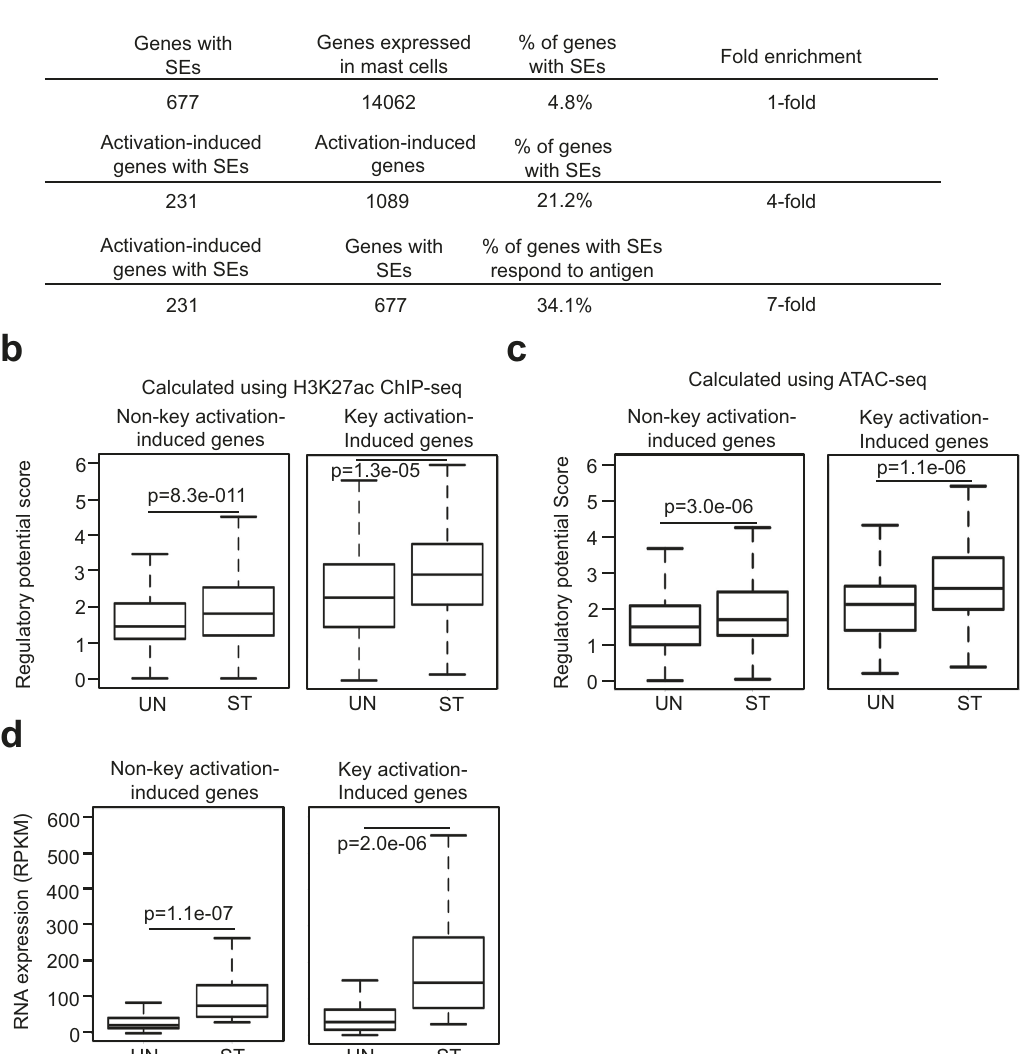
Fig. 5 Super-enhancers are enriched in the key activation-induced genes. a SEs are enriched in the key activation-induced genes. b The regulatory potential scores for TEs of the non-key activation-induced genes and SEs of the key activation-induced genes in resting (UN) or activated (ST) MCs were calculated either using H3K27ac ChIP-seq peaks ( b ) or using Omni-ATAC-seq peaks ( c ). d Average FPKM reads of RNA transcripts of the non-key activation-induced genes and key activation-induced genes in resting or activated mast cells ( n = 3 biologically independent samples). Data a – c represent three biological samples. Middle line inside each box represents the median, upper and lower bounds of the box represent the third and fi rst quartiles, respectively. Whiskers represent 1.5 times of the interquartile range. P -values were calculated by a two-tailed student ’ s t test without